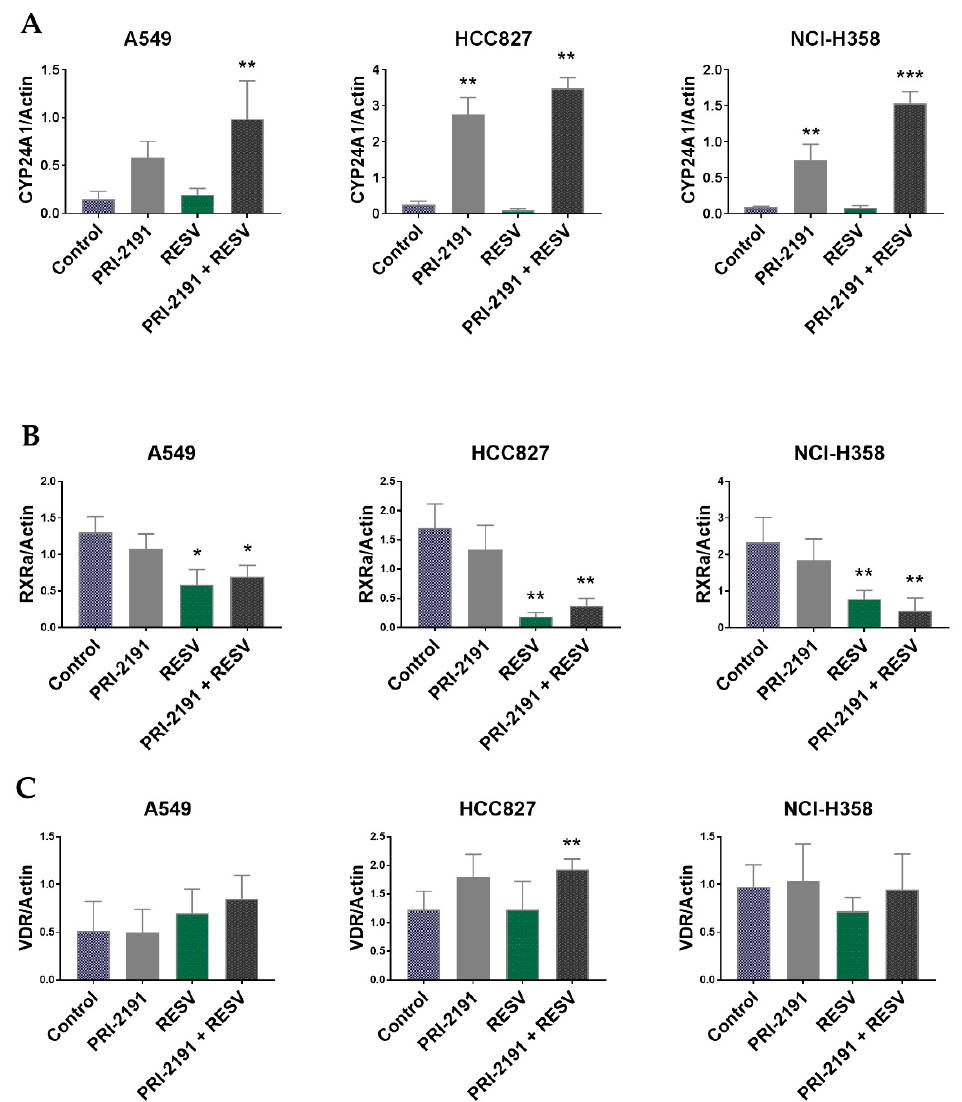
Figure 5. Western blot analysis of lung cancer cells treated with PRI-2191 (100 nM) and RESV (20 µ M). Effect of PRI-2191 and RESV on ( A ) CYP24A1, ( B ) RXR α , and ( C ) vitamin D receptor (VDR) expression in lung cancer cells (all blots and statistical analysis for other cell lines are presented in Figure S7). Cell lysates were subjected to SDS-polyacrylamide gel electrophoresis and analyzed by Western blotting. Actin was used as a normalization control. * Compared to control (untreated cells); ** compared to control and RESV (for RXR α compared to control and PRI-2191); *** compared to control, RESV, and PRI-2191 ( p < 0.05, one-way ANOVA with Tukey’s post hoc with mul- tiple comparisons).